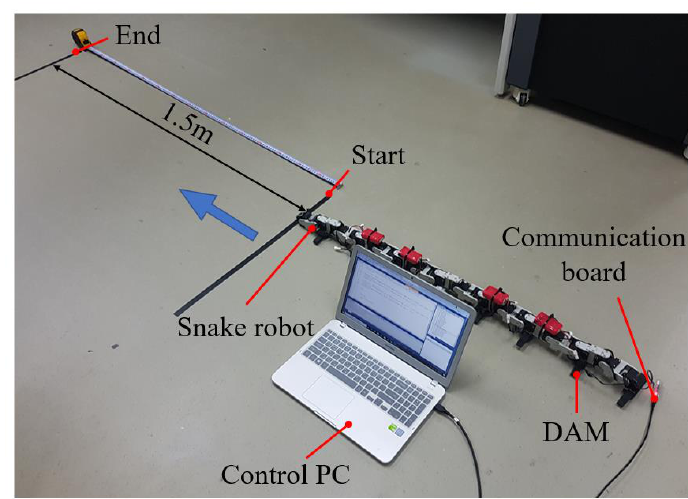
Figure 9. Configuration for flatland experiment.